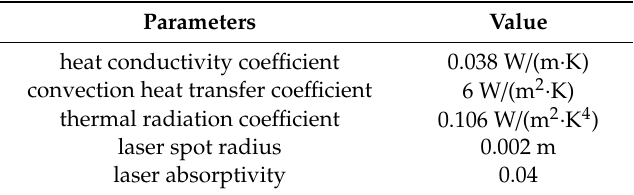
Figure 9. Sintering mechanism of SLS process. Figure 10 shows that the part size exerts a great effect on the temperature field. When the dimensions of part are larger, a reciprocating laser scanning time is longer, resulting in the decrease of temperature of the sintered part. At the same time, the preheating effect of adjacent powder begins to reduce, resulting in a large temperature gradient and shrinkage. Figure 10b shows the temperature distribution when the dimension of part lets up the half. Compared to Figure 10a, it can be concluded that the temperature gradient reduces with the decreasing of part dimension. It is helpful to reduce parts warpage and shrinkage.